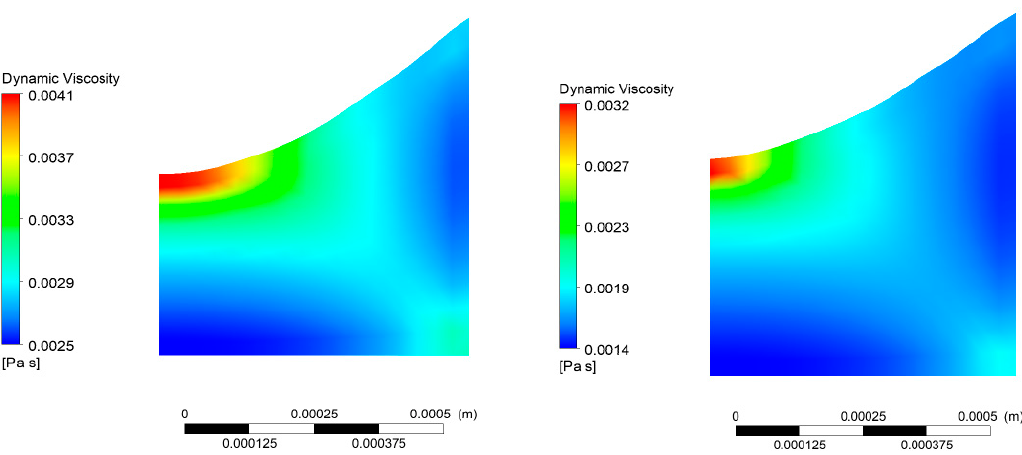
Figure 8. Dynamic viscosity distribution on a cross section located 30 W O downstream from the channel entrance ( left to right ) : nW _40; nG 20_40 .